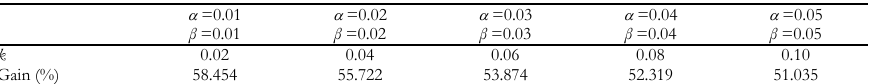
A verage percentage of size of sample with the generalized modified SPRT analysis as compared with current most powerful test for testing mean of the normally distributed variate for α + β = k with α = β α =0.01 α =0.02 α =0.03 α =0.04 α =0.05 β =0.01 β =0.02 β =0.03 β =0.04 β